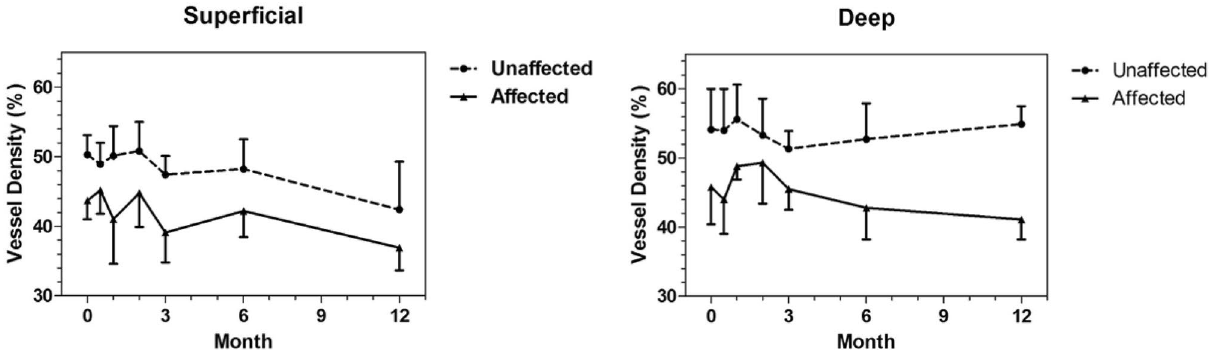
Figure 2. Mean extralesional vascular density of the superficial and deep capillary plexus at each time point between affected and unaffected eyes. Standard deviations were defined by vertical